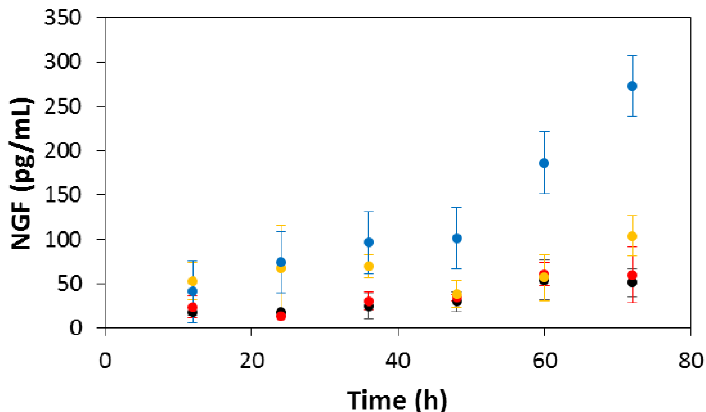
Figure 8. Concentration of Schwann cell-produced NGF in the culture medium. Black circles) commercially available tissue-culture treated Corning ® Costar ® tissue culture plates. (Red circles) non-electroactive PCL-based tissue scaffolds. (Yellow circles) electroactive PCL-based tissue scaffolds without electrical stimulation. (Blue circles) electroactive PCL-based tissue scaffolds with electrical stimulation. Error bars represent standard